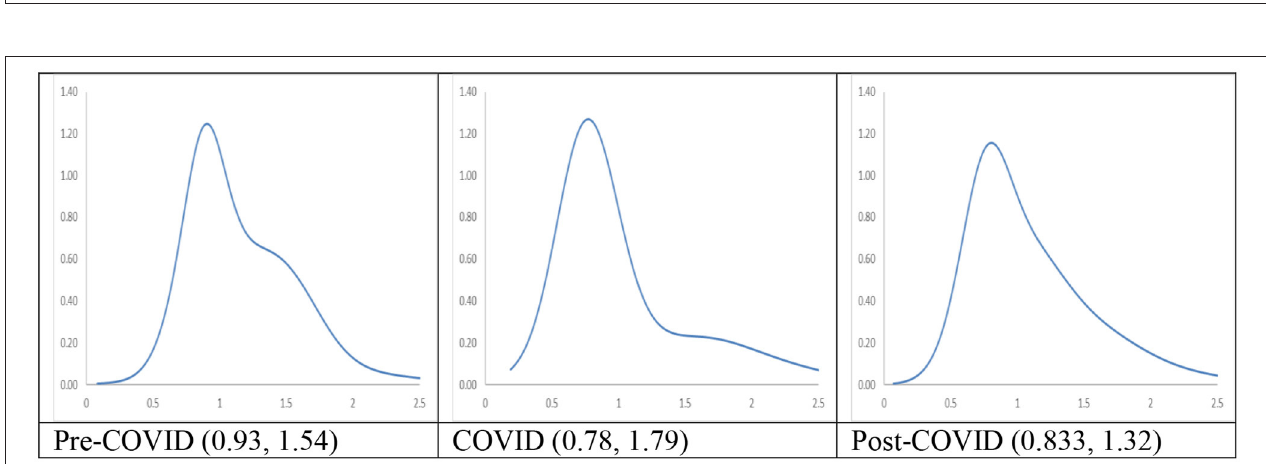
FIGURE 3 | Ergodic distributions for the RDIPC of all cities with the longest Level I ERS duration. Source: authors’ calculation. N.B. The vertical axis indicates the density of probability, the horizontal axis indicates RDIPC values, and the value of the peaks are in parentheses.